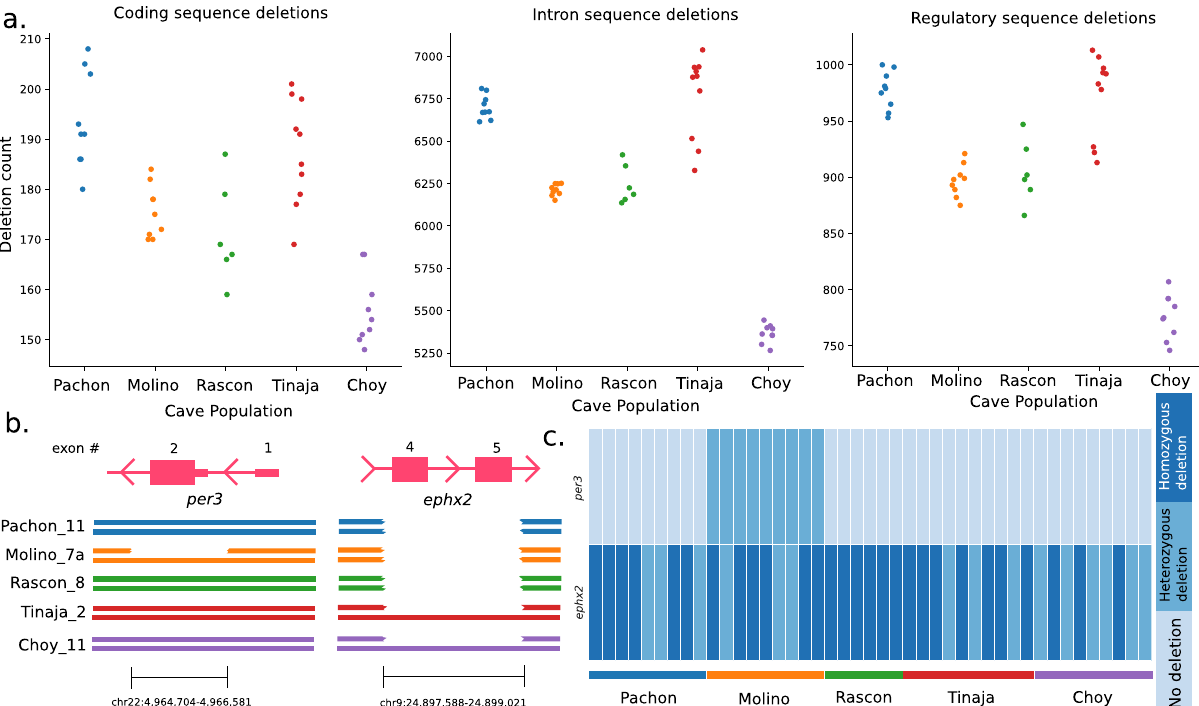
Fig. 4 Sequence deletion events characterized by population origin. a Total deletion count per population for protein-coding exons and intron sequence and regulatory sequence de fi ned as 1000 bp up- or downstream of annotated protein-coding genes. b Gene sequence deletion coordinates for the circadian rhythm gene per3 and cholesterol regulatory gene ephx2 by population. c The allelic state of each deletion distributed by individual sample per